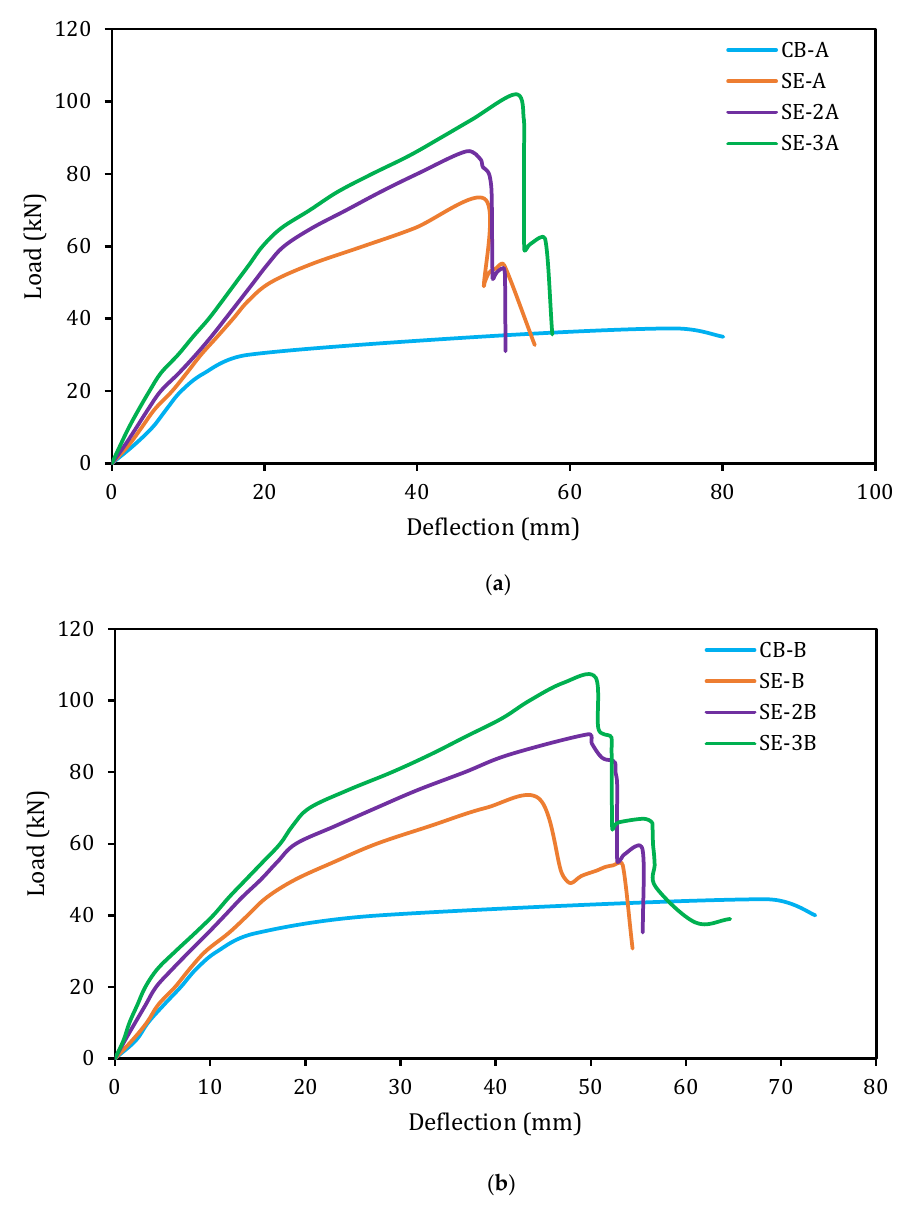
Figure 7. Load – deflection graphs. ( a ) series-A; ( b ) series-B. Figure 7. Load–deflection graphs. ( a ) series-A; ( b )